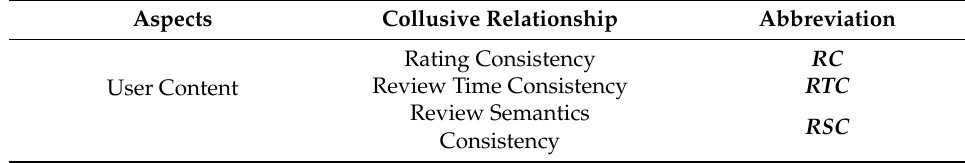
Table 1. User Multiple Collusive